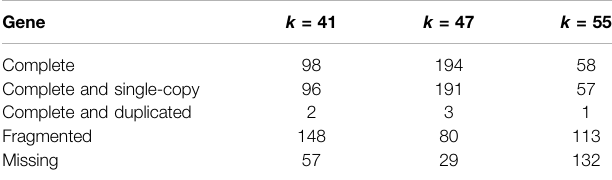
TABLE 1 | Results from the search of a set of 303 core eukaryotic orthologous genes in alternative assemblies performed with different k -mer values, according to